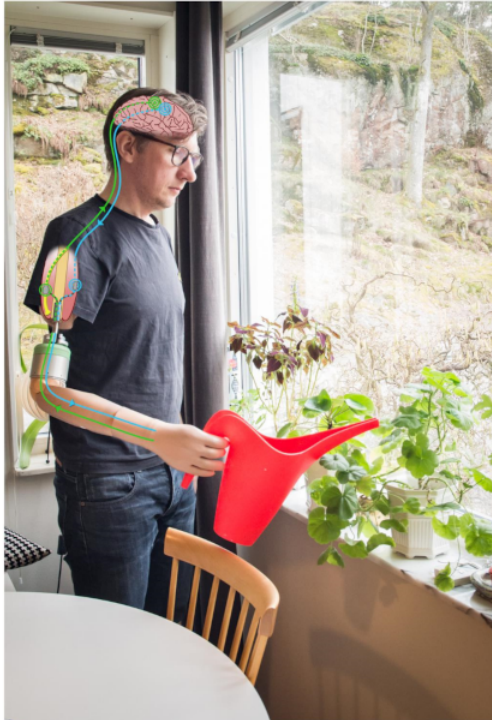
Figure 8. Bidirectional interaction between the prosthetic hand and implanted electrodes was made possible by implantation. Reprinted with permission from